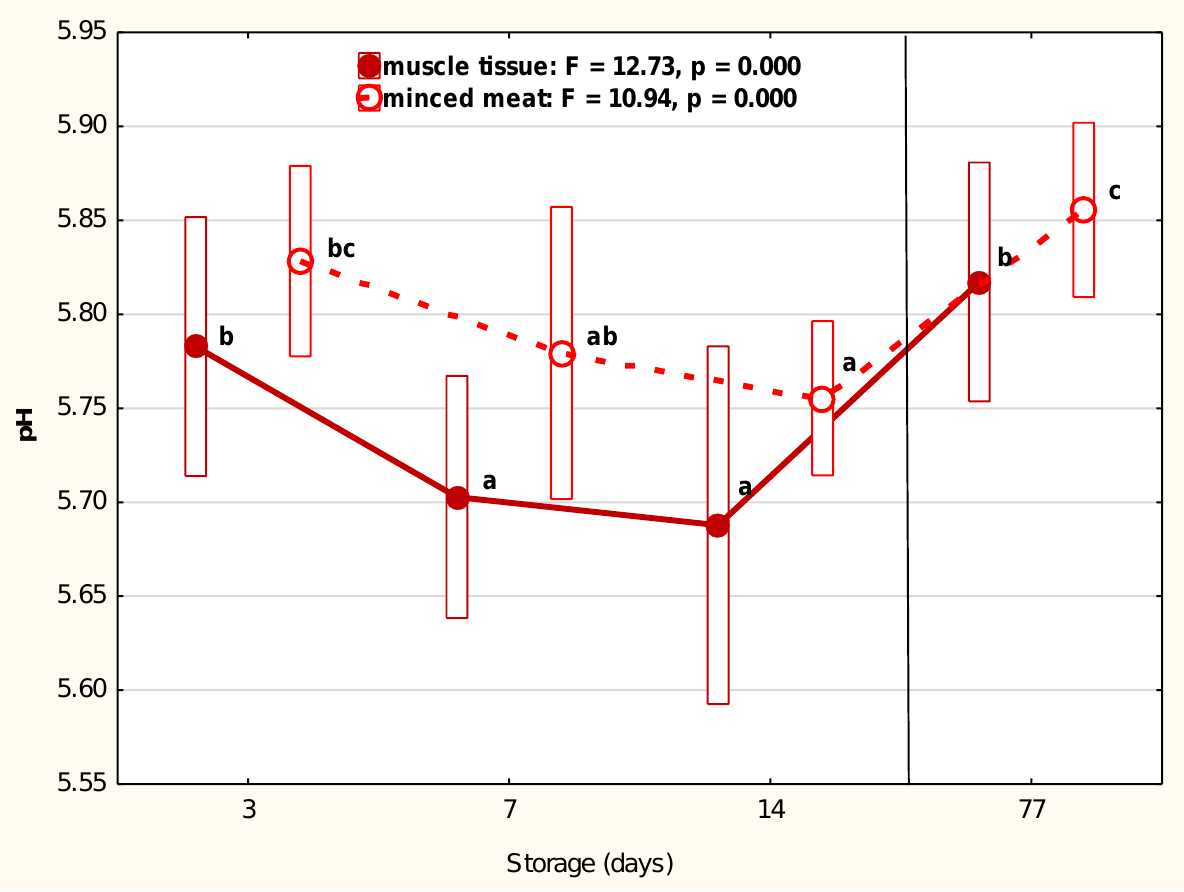
Figure 1. The pH of muscle tissue and minced meat of beaver during refrigerated (1, 7, 14 days) and frozen (77 days) storage. Red filled dots represent the average pH value of muscle tissue. The continuous line represents the trends in changes between storage days. The red empty dots represent the average pH value in minced meat. The dotted line represents the trends in changes between storage days. Bars represent the standard deviation. The mean values marked with letters (a, b, c) differ statistically at p ≤ 0.05.